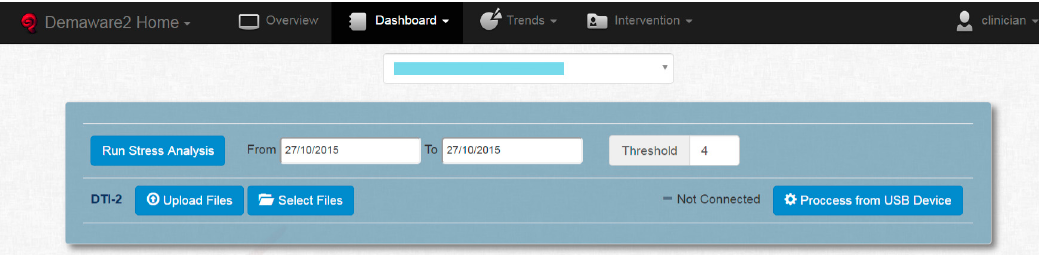
(“Threshold”) for each user (anonymized drop-down menu) and time period (“From”–“To” fields).